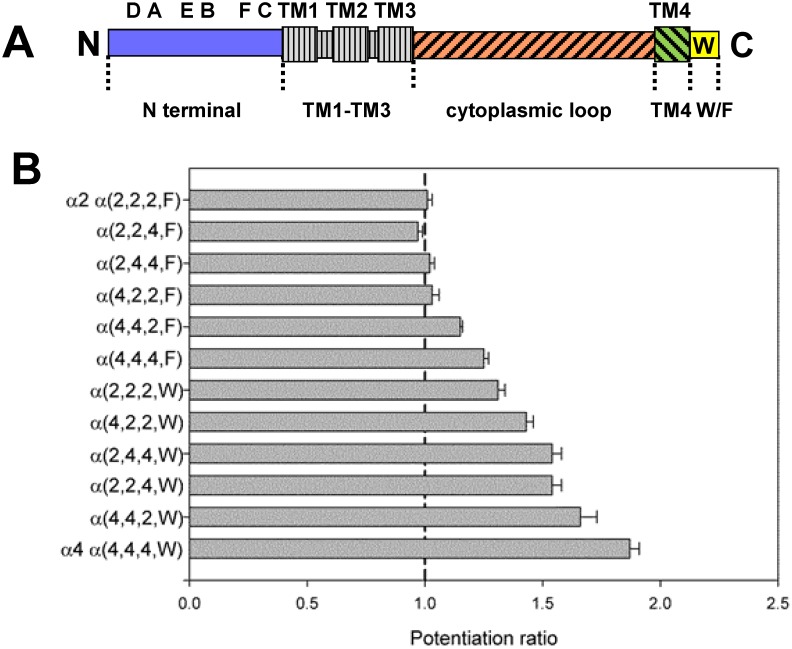
Chimeric subunits used to determine regions contributing to potentiation by βEST.Panel A shows a linear cartoon of a nicotinic subunit, with the amino-terminus (“N”) at the left. Some major structural features are indicated: in the amino-terminal extracellular domain there are 6 domains involved in agonist binding, the A, B, C loops contributed by the α subunit and the D, E, F loops contributed by the β subunit. The 4 transmembrane regions are indicated by the enlarged boxes; the channel is formed by TM2 helices contributed by the 5 subunits in the receptor. The 4 regions studied were the N-terminal domain (blue; extending from the amino-terminus to V(210)IRRLP sequence at the start of TM1 (the amino acid residue numbering is for the mature α4 subunit; NCBI Reference Sequence: NP_000735.1). The TM1-TM3 regions (gray with vertical hatching) are identical in the mouse α2 and human α4 subunits. The region called the cytoplasmic loop (red with forward hatching) extends from N(301)VHHRSP at the end of TM3 to D(571)RIFL at the start of TM4. TM4 (green with backwards hatching) is the region from D(571)RIFL to FLP(592)P. The tryptophan in α4 is in the carboxy-terminal region, W(594)LAGMI. The cytoplasmic loop is highly divergent in nicotinic subunits, and contains between about 150 and 270 amino acids. Panel B shows the mean potentiation ratio for the chimeras studies. Chimeras are identified by which subunit contributed the relevant portion of the construct, so α(2,2,4,W) indicates an α subunit with α2 sequence in the amino-terminus, α2 sequence in the cytoplasmic loop, α4 sequence in the TM4 region and W in the C-terminal tail. The figure shows the mean ± SE potentiation ratio produced by βEST (see Table 2 for numbers of observations).